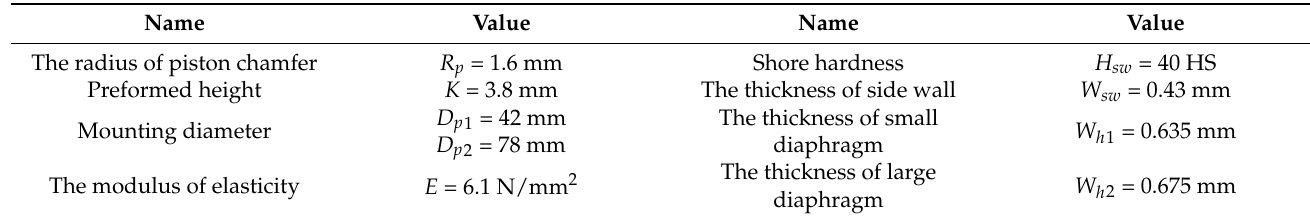
Table 3. The structural parameters of rolling diaphragm.